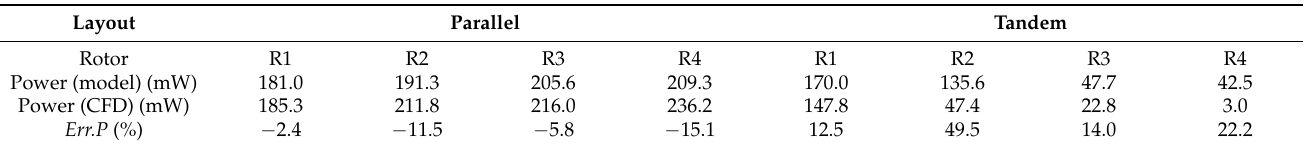
Table 2. Comparison of each rotor power in the parallel and tandem layouts between the present model and the CFD